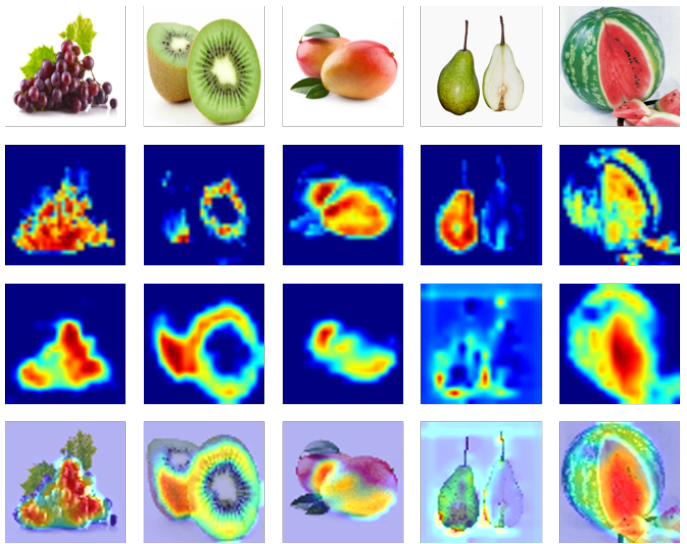
Figure 15. Visualizations of the feature map and class-specific discriminative regions for the predicted examples from the attention module of our proposed